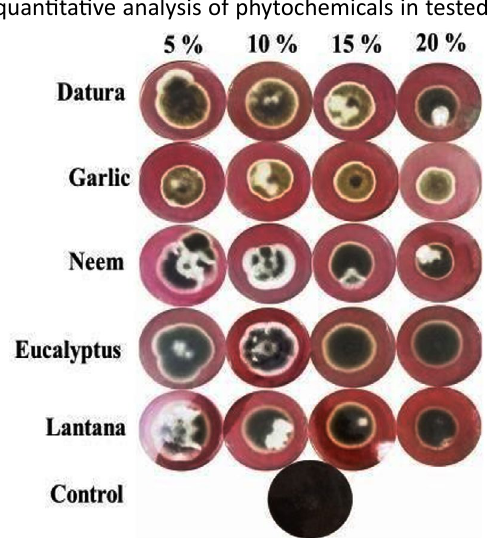
Fig. 2. Mycelial growth of Alternaria solani at different concentration of plant extracts after seven days of